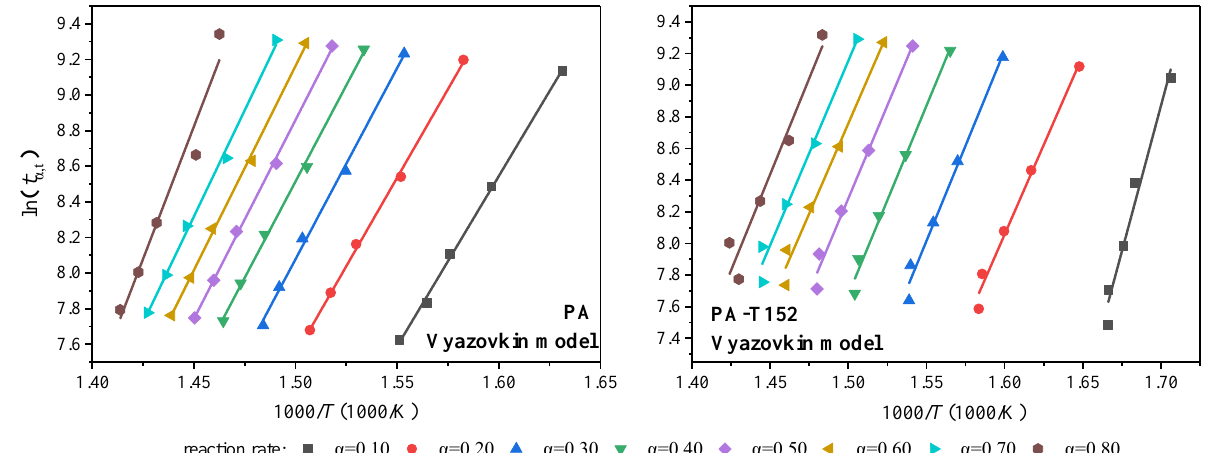
Figure 7. Calculation of E a from TG curves for PA and PA-T152 using FWO model.